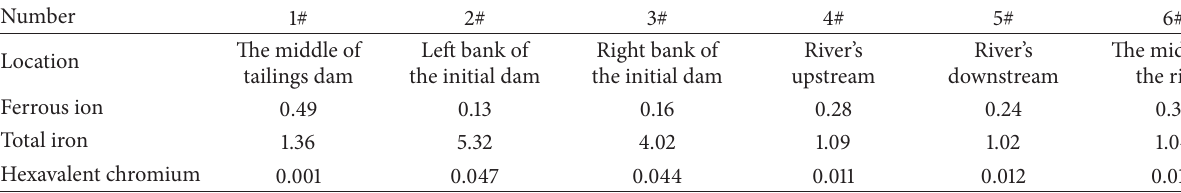
Table 1: Three ion concentrations of the Lixi tailings dam at different sites (mg/L).